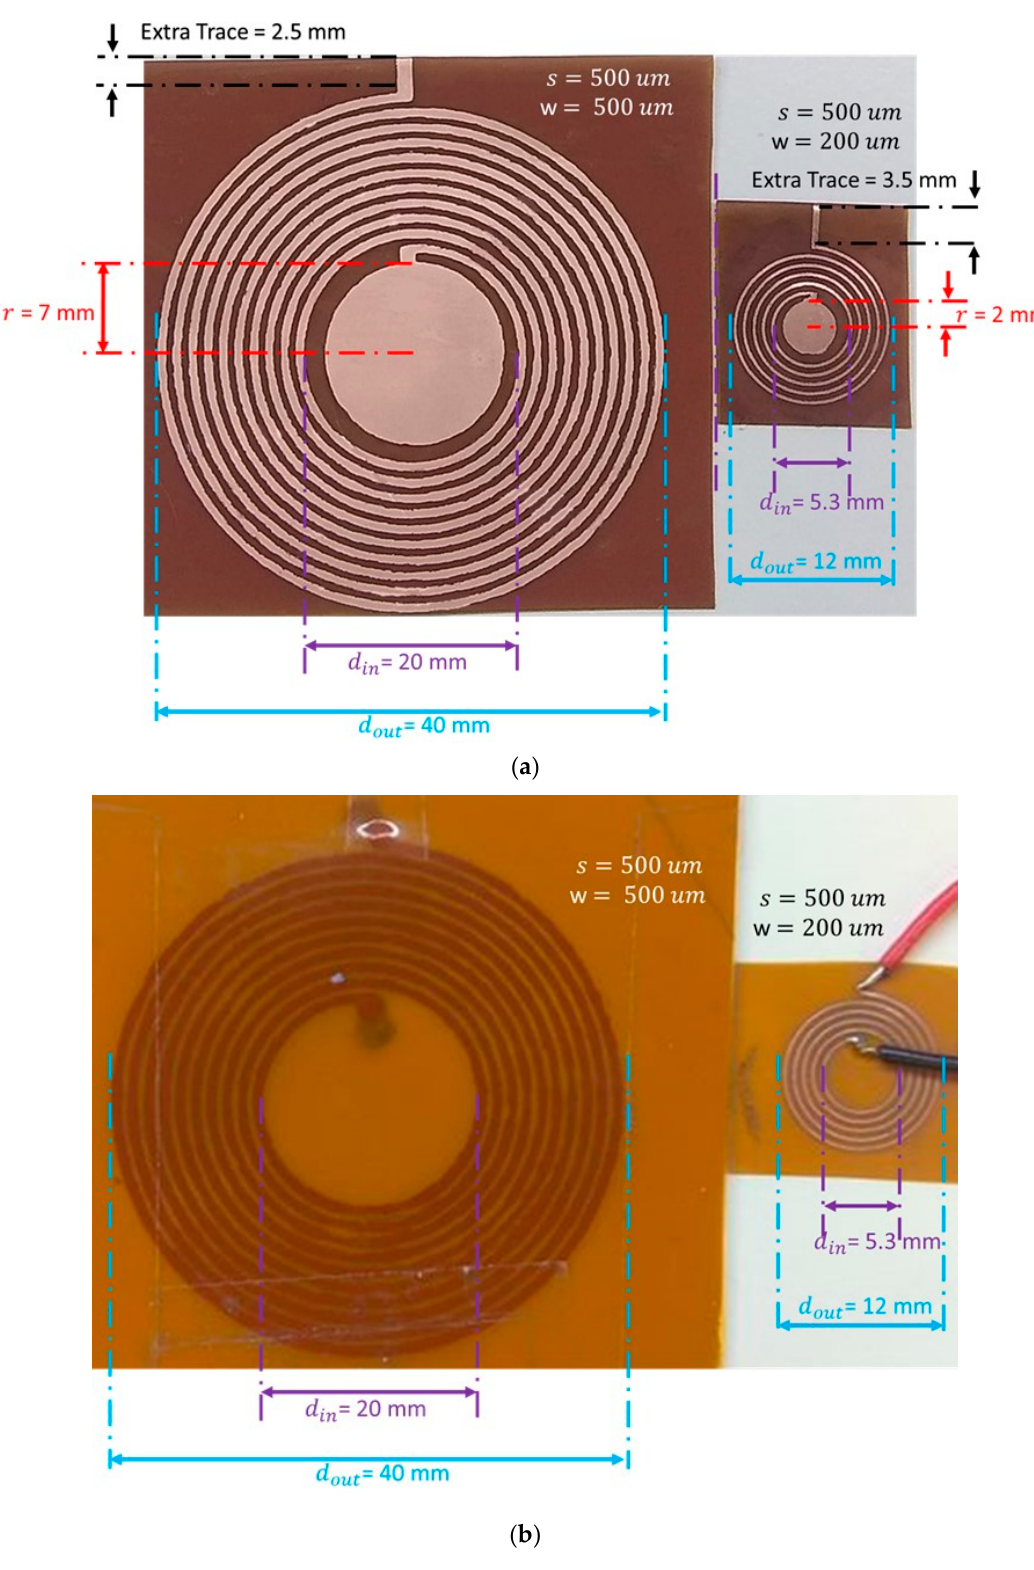
Figure 10. Fully labeled images of final prototypes, ( a ) Fabricated wireless LC resonance sensors: left, S 1 (40 mm in diameter), and right, S 2 (12 mm diameter); ( b ) Reader coils for S 1 ( left ) and S 2 ( right ).